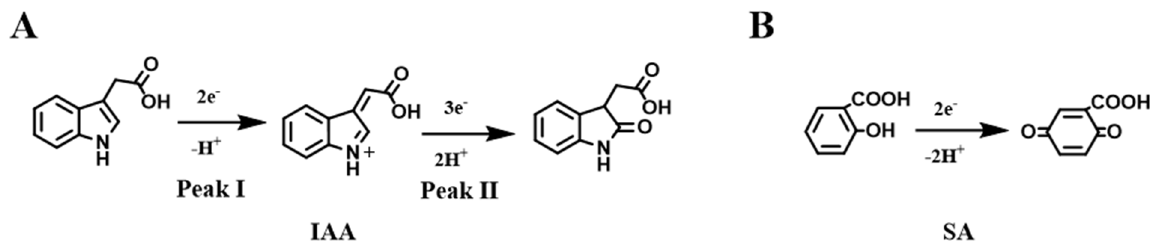
Figure 8. Possible electrochemical oxidation reactions of IAA ( A ) and SA ( B ).